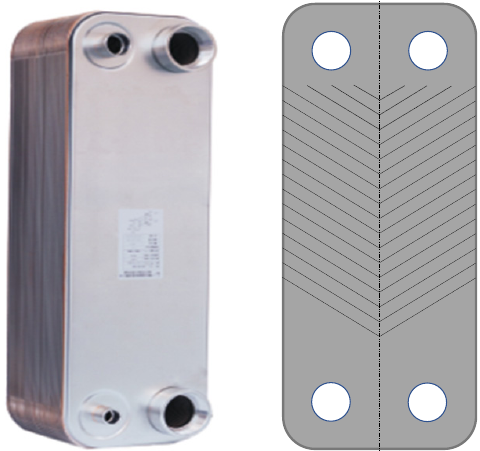
Figure 2. Structural schematic of a herringbone plate heat exchanger [30]. Reproduced with per- mission from Luo et al., Energy; published by Elsevier, 2022.